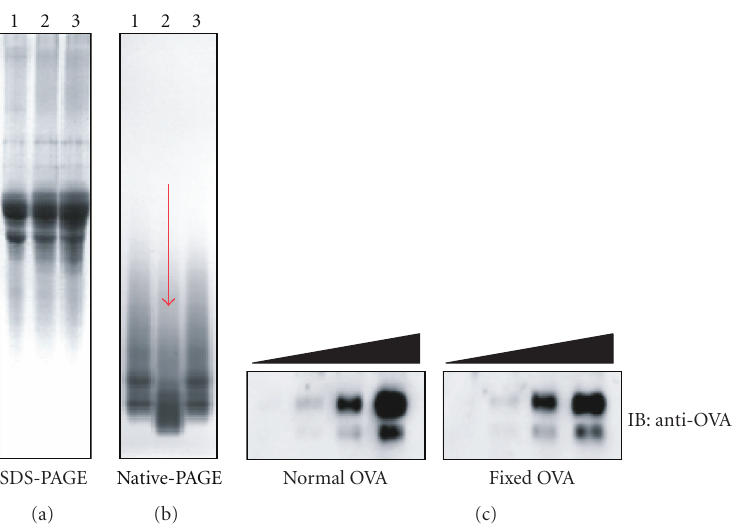
Figure 1: Paraformaldehyde-fixed OVA migrates faster than native OVA in native-PAGE but retains its immunoreactivity. Native OVA (lane 1), paraformaldehyde-fixed OVA dialyzed against PBS (lane 2), and native OVA dialyzed against PBS (lane 3) were analyzed by SDS- PAGE (a) and native-PAGE (b). (c) Native OVA and fixed OVA (1, 0.2, 0.04 μ g/lane each) were run on SDS-PAGE, and western blot was performed using anti-OVA polyclonal